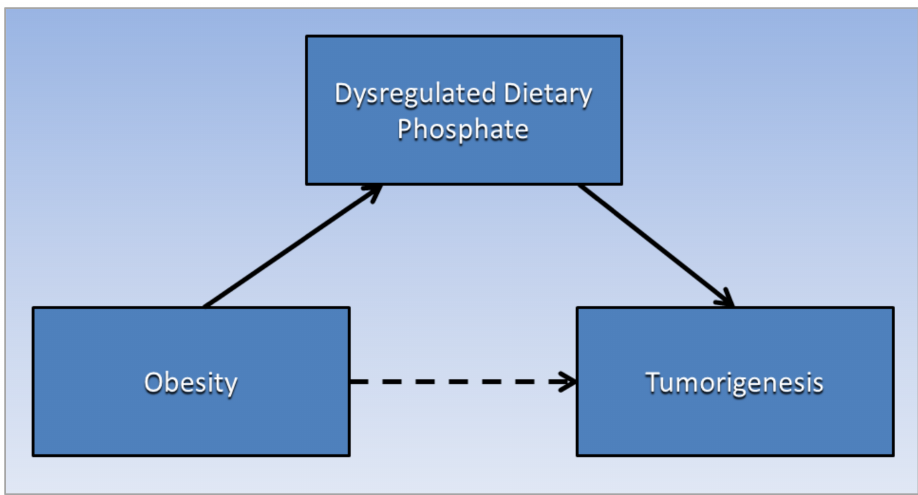
Figure 2. Obesity increases levels of dysregulated dietary phosphate, which mediates the association between obesity and